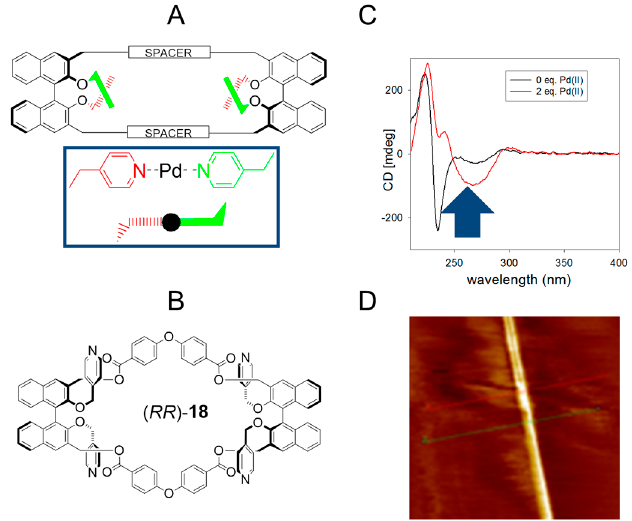
Figure 15. ( A ) Cartoon representation of the design; ( B ) chemical structure of the D 2 symmetrical macrocycle ( RR )- 18 ; ( C ) CD spectra of the macrocycle, and of the aggregates in MeCN solutions upon addition of two equivalents of the bidentate Pd 2+ ; and ( D ) AFM images of fibers formed by ( RR )- 18 , C60 and PdCl 2 (MeCN) 2 , with cross section of ca. 1 nm. Partially reproduced with permission from Ref. [62] (Copyright Royal Society of Chemistry, 2015).